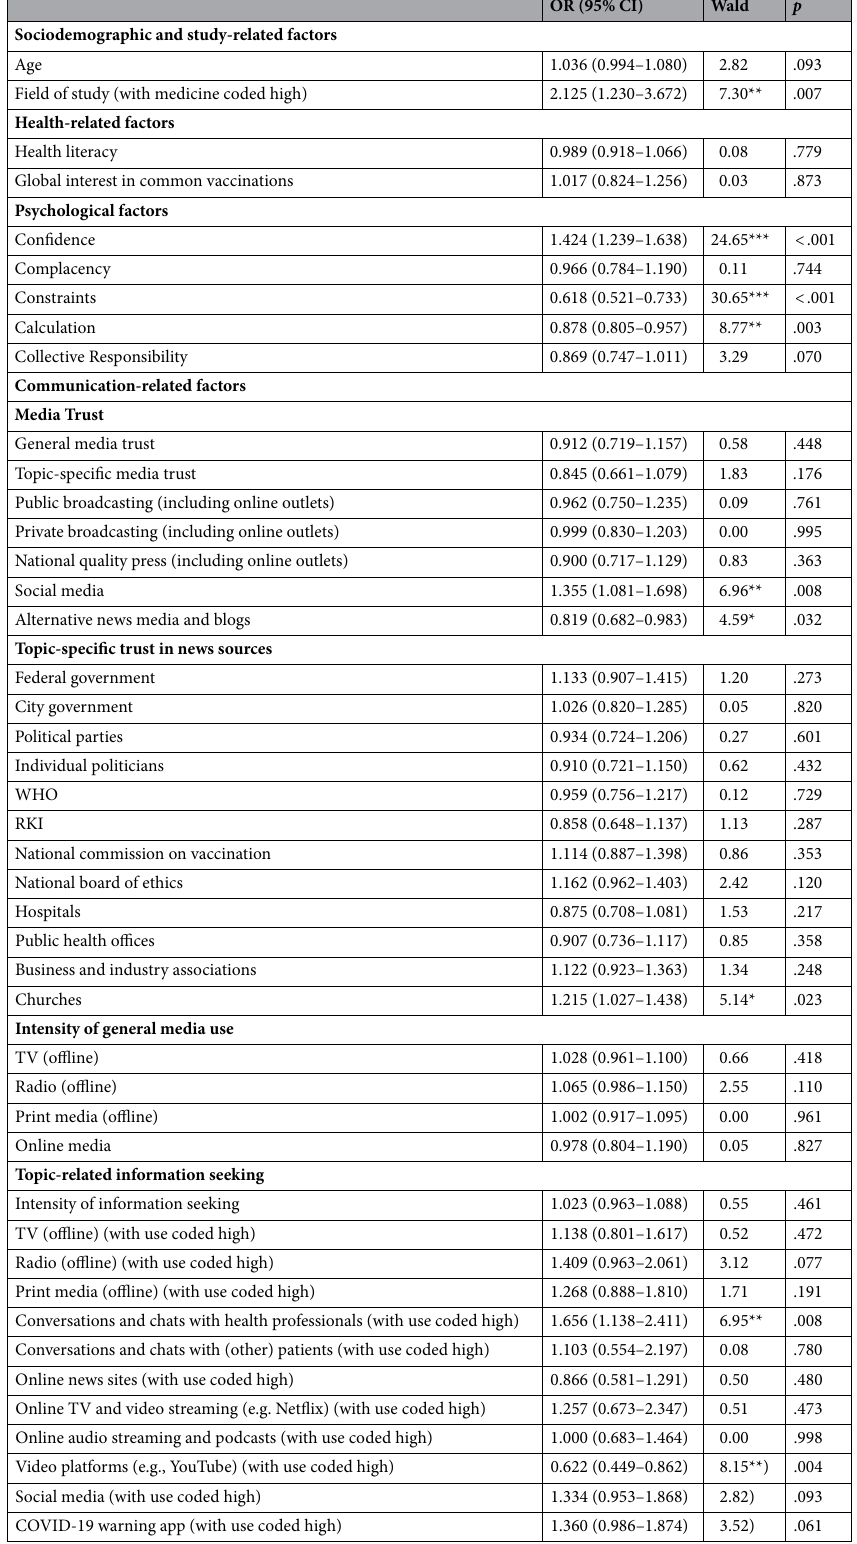
Table 2. Associations of sociodemographic, study-related, psychological, health-related, and communication- related factors with the likelihood of a vaccination against COVID-19 among university students in the summer of 2021. Binary logistic regression analysis. χ 2 (44) = 276.33, p < .001, n = 1,114; Nagelkerke R 2 = .311; Cohen’s f 2 = . 45. * p < .05; ** p < .01; *** p <